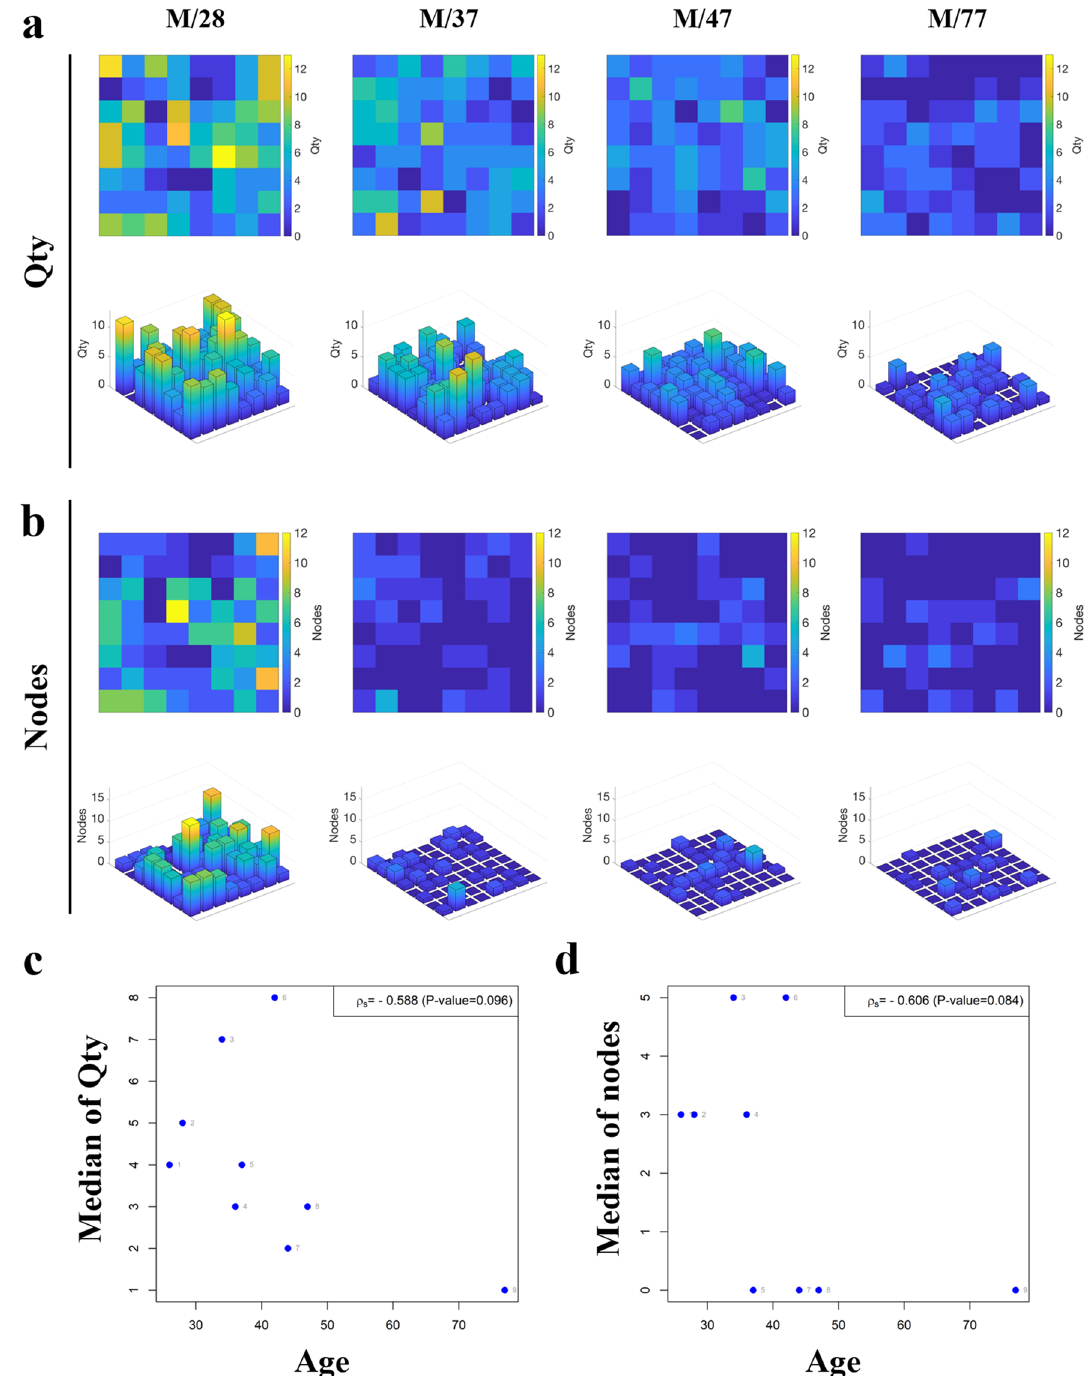
Figure 4. The graphical presentation of age-related changes in previously well-known quantified parameters, ( a,c ) number of nerve fibers (Qty), and ( b,d ) nodes. ( a,b ) Each color in 2-D color maps reflected the degree of quantified results regarding higher values as bright yellow to lower one to dark blue. ( a,b ) The quantified results are presented as 3-D bar graphs, while the height of the bar shows the degree of parameters in each